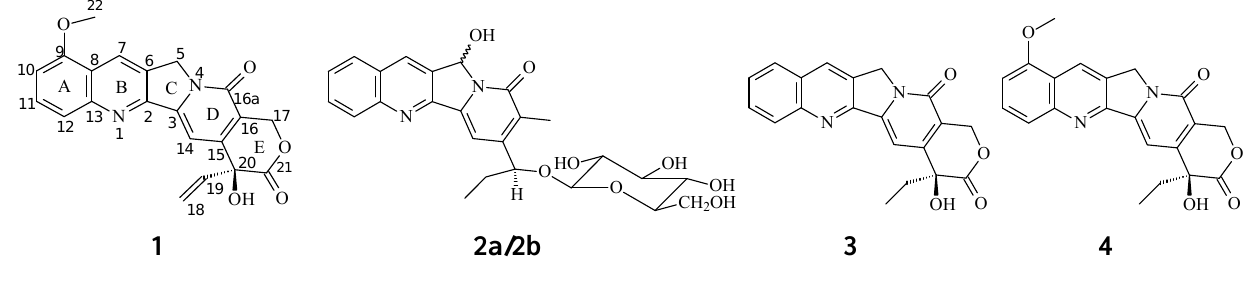
Figure 1 . The structures of compounds 1 - 4 from N. foetida